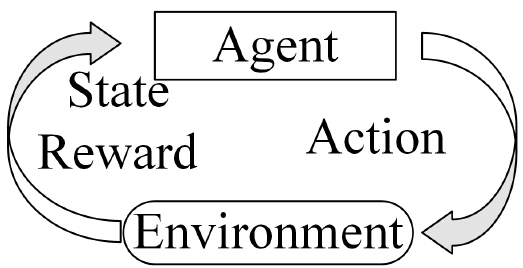
Figure 3. The sketch of reinforcement learning, in which the agent guides the choice of actions according to the state feedback information given by the environment, and the choice of actions affects the changes of the environment, thereby updating the parameters.